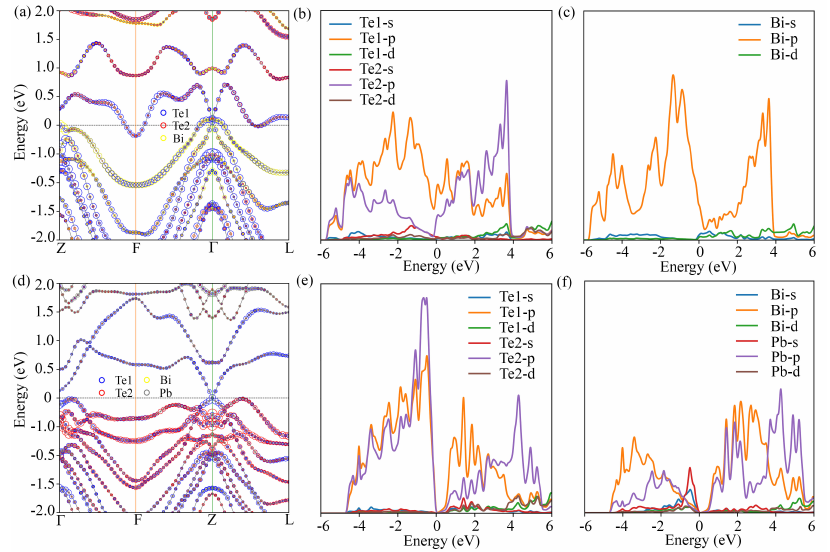
Figure 12. Band structure and PDOS of bulk Bi 2 Te 3 ( a – c ) and bulk PbBi 2 Te 4 ( d – f ) with SOC. The size of the colored circles is proportional to the partial weights of the atomic states.